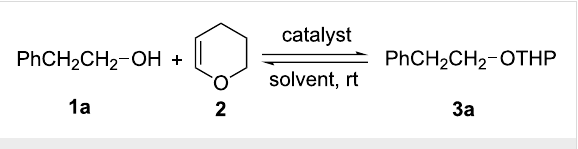
Scheme 1: Synthesis of THP ether 3a